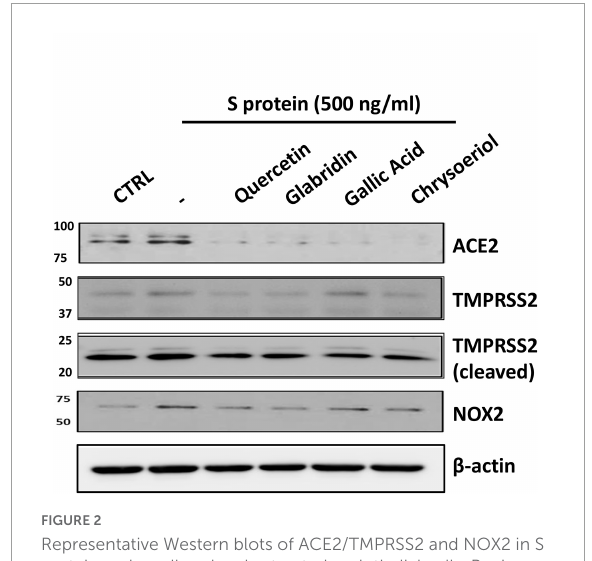
FIGURE2 Representative Western blots of ACE2/TMPRSS2 and NOX2 in S protein and small molecules treated endothelial cells. Bovine aortic endothelial cells (BAECs) were pretreated with viral spike protein (S protein, 500 ng/ml) for 30 min before exposure to 100 nmol/l of small molecule compounds for 24 h. Shown are representative Western blots of ACE2, native/cleaved TMPRSS2 and NOX2 in S protein, and small molecules treated endothelial cells.